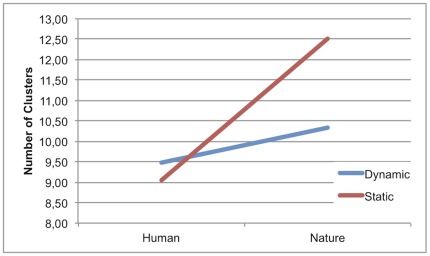
Number of clusters in Content×Dynamism.